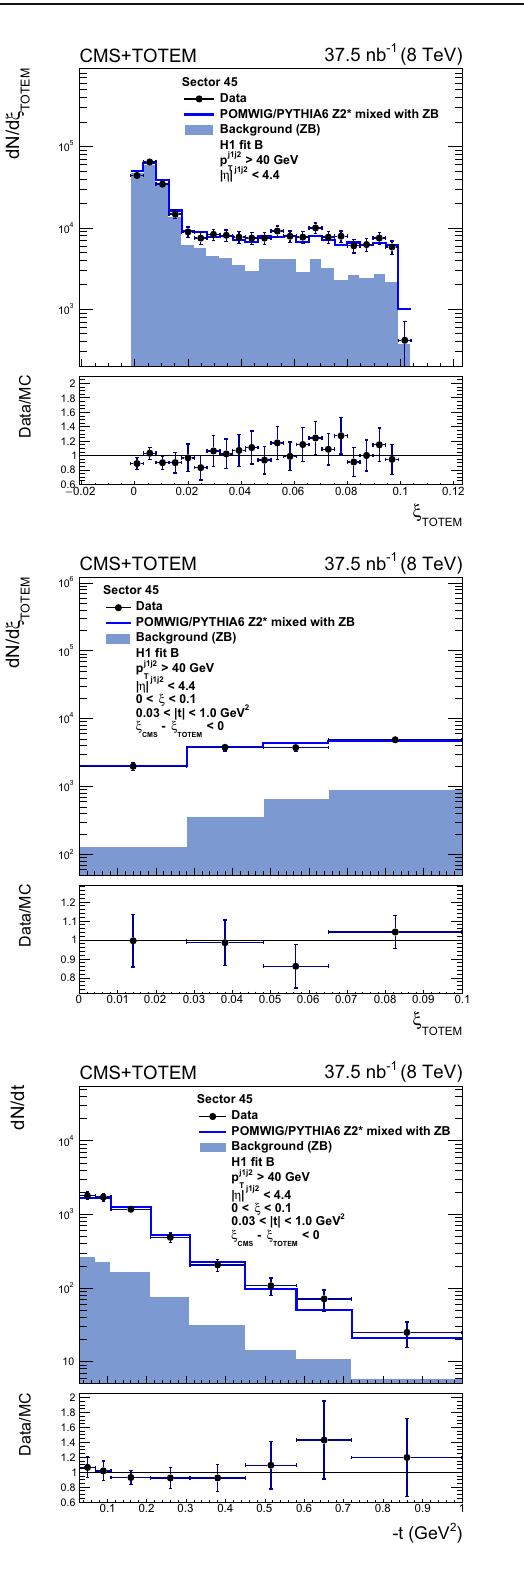
Fig. 3 Distribution of ξ TOTEM before (upper) and after (middle) the ξ − ξ CMS TOTEM requirementanddistributionof t afterthe requirement (lower) for events in which the proton is detected in sector 45 (left) and sector 56 (right). The data are indicated by solid circles. The blue histogram is the mixture of pomwig or pythia6 and zero bias